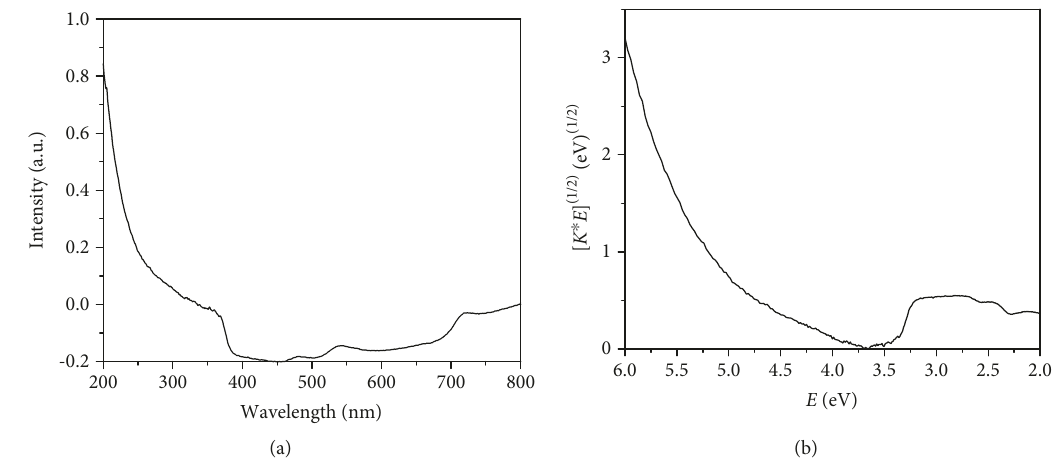
Figure 4: (a) DRS absorption plot and (b) Tauc plot of the AC-ZnO